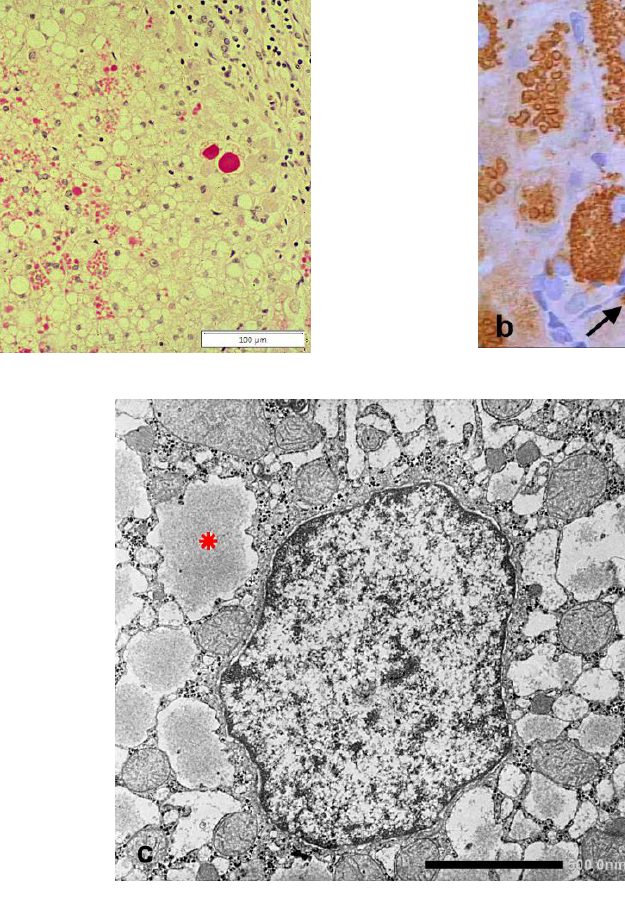
Figure 1. Pi ZZ liver specimen. The vast majority of hepatocytes contain PAS–D inclusions of variable size ( a : PAS–D × 10). The inclusions are positive on immunostaining with the monoclonal AZT11 antibody ( b × 100). The electronmicrophoto- graph shows a hepatocyte with dilated cisternae of the RER containing AAT-like material (*) ( c : EM × 15,725).